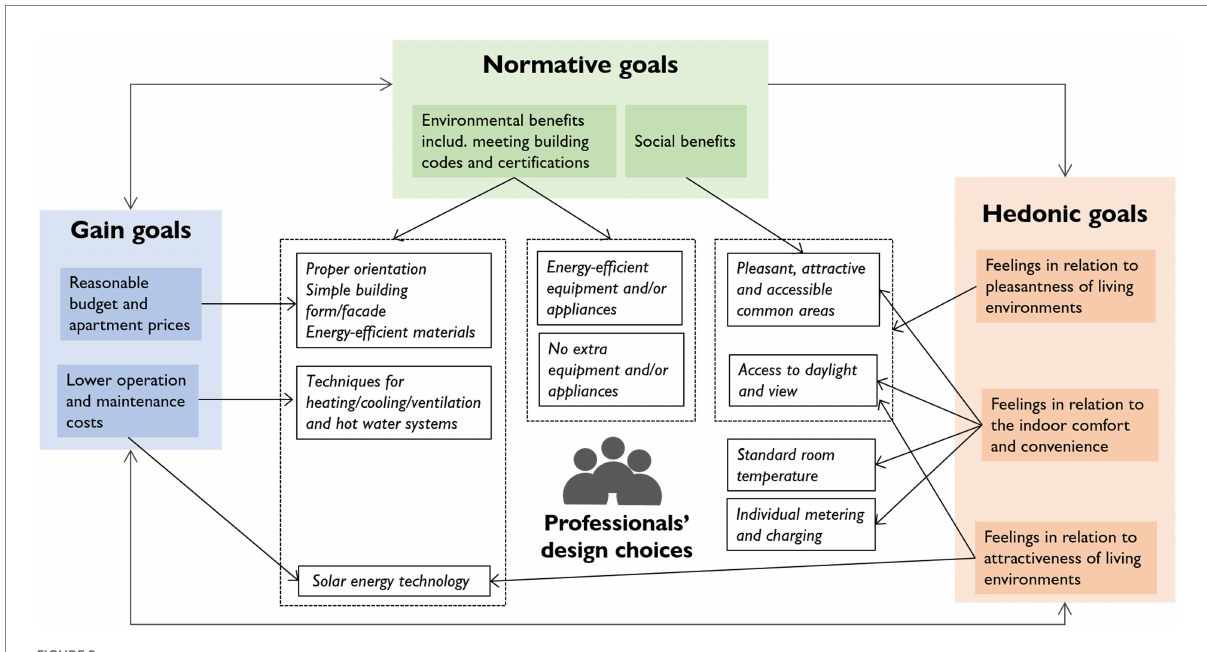
FIGURE 2 Relationships between the goals and their influence on design choices (indicated by the arrows between the